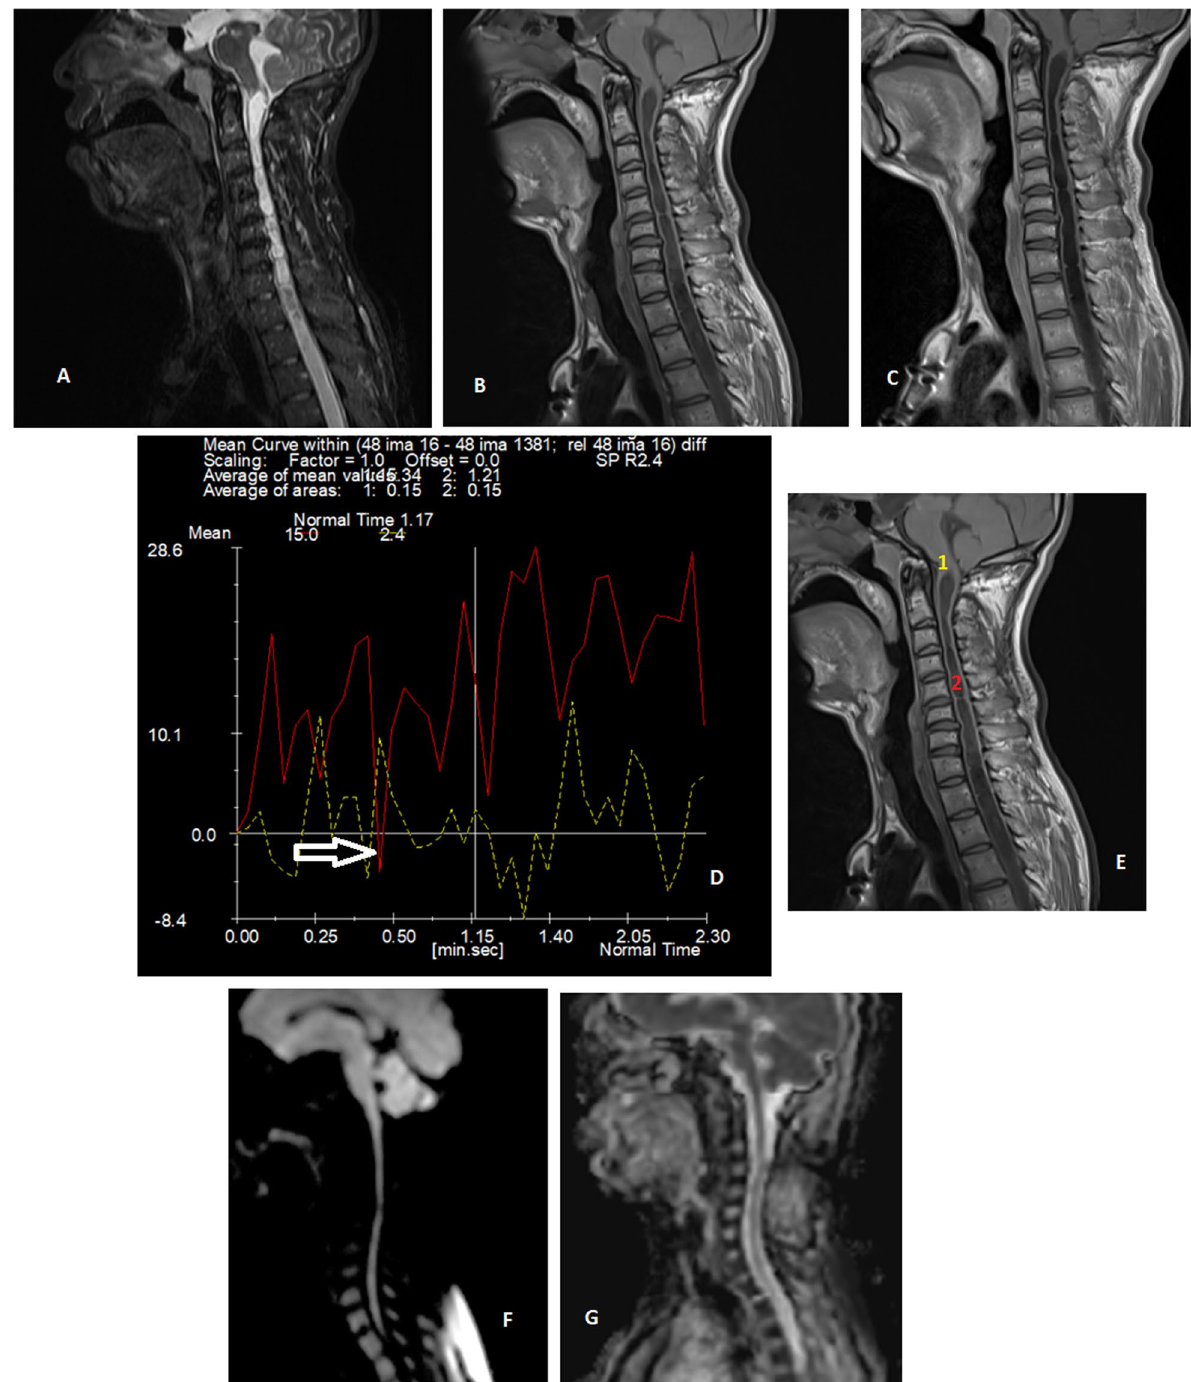
Fig. 7 23-year-old male presented with headache. T2 sagittal cervical spine ( A ) shows long segment of CSF signal intensity involving cervical and upper dorsal cord. Pre-contrast T1 ( B ) and post-contrast T1 ( C ) show CSF signal intensity of the lesion with no post-contrast enhancement. D and E rCBV was calculated in comparison to normal cord (yellow curve) and the curve shows hypo perfusion of the lesion (arrow to red curve). DWI at b value 1000 ( F ) shows no areas of high signal intensity within cord at site of lesion which appears also at ADC map ( G ) denoting free diffusion. This = lesion was diagnosed as syrinx associated with Chiari I